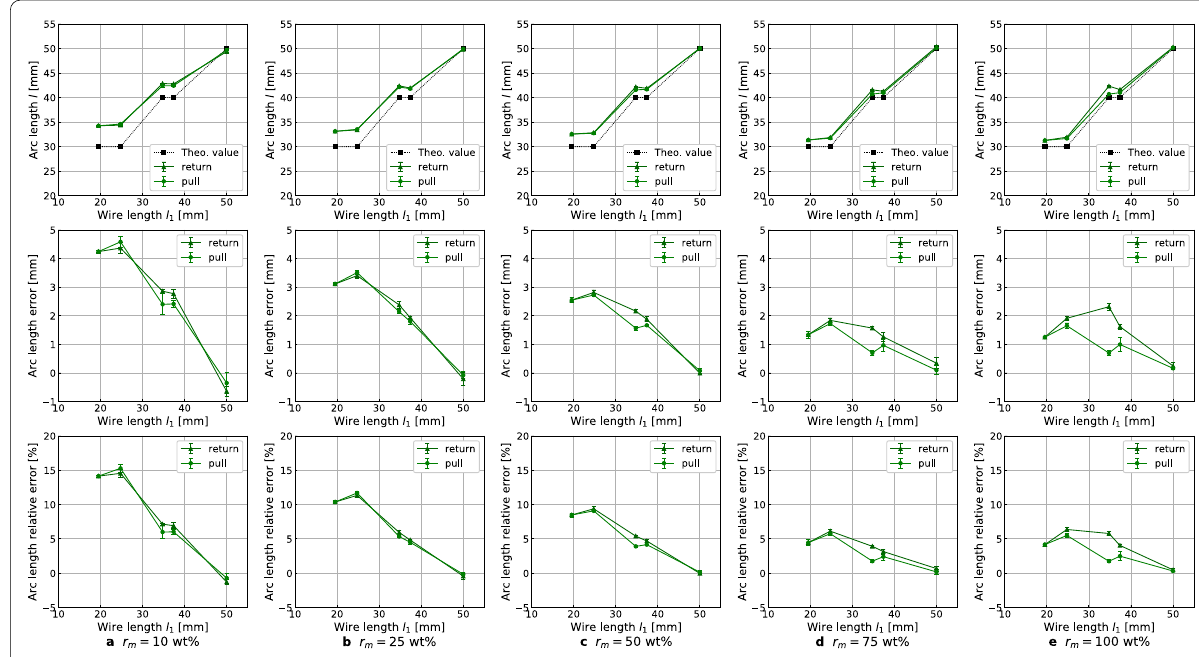
Fig. 14 Neutral arc length l (top), its error (middle), and relative error (bottom) to wire length l 1 for each plasticizer mixing ratio in deformation pattern (b). Each plot represents the mean value of the three times. The error bars represent the standard deviation